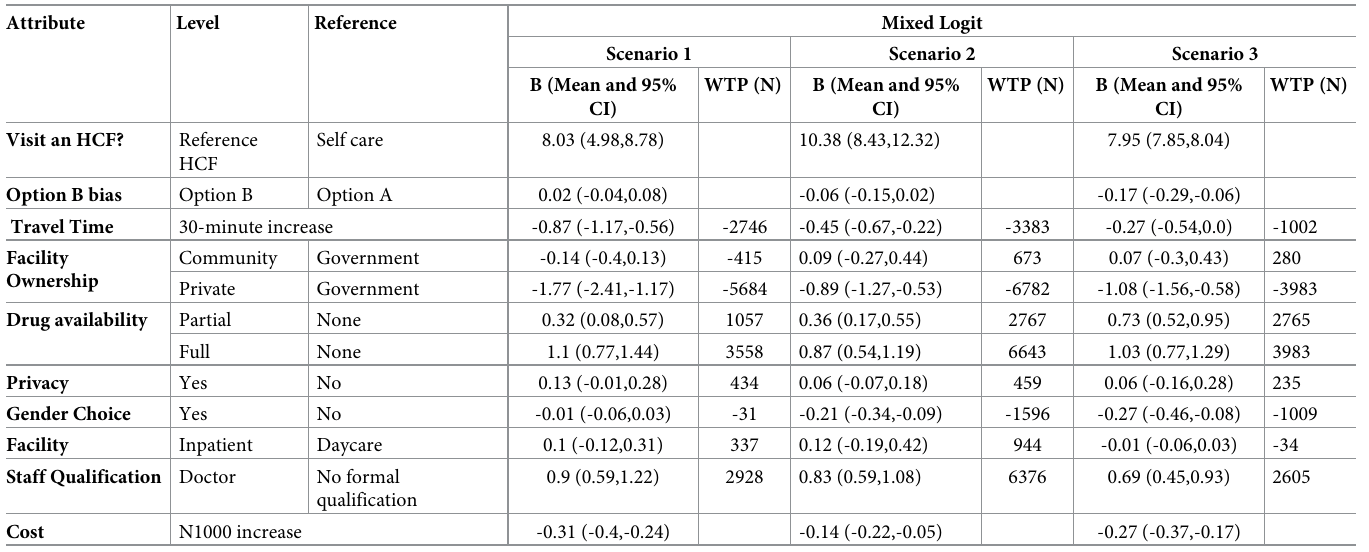
Table 5. Mixed logit model results for each scenario.